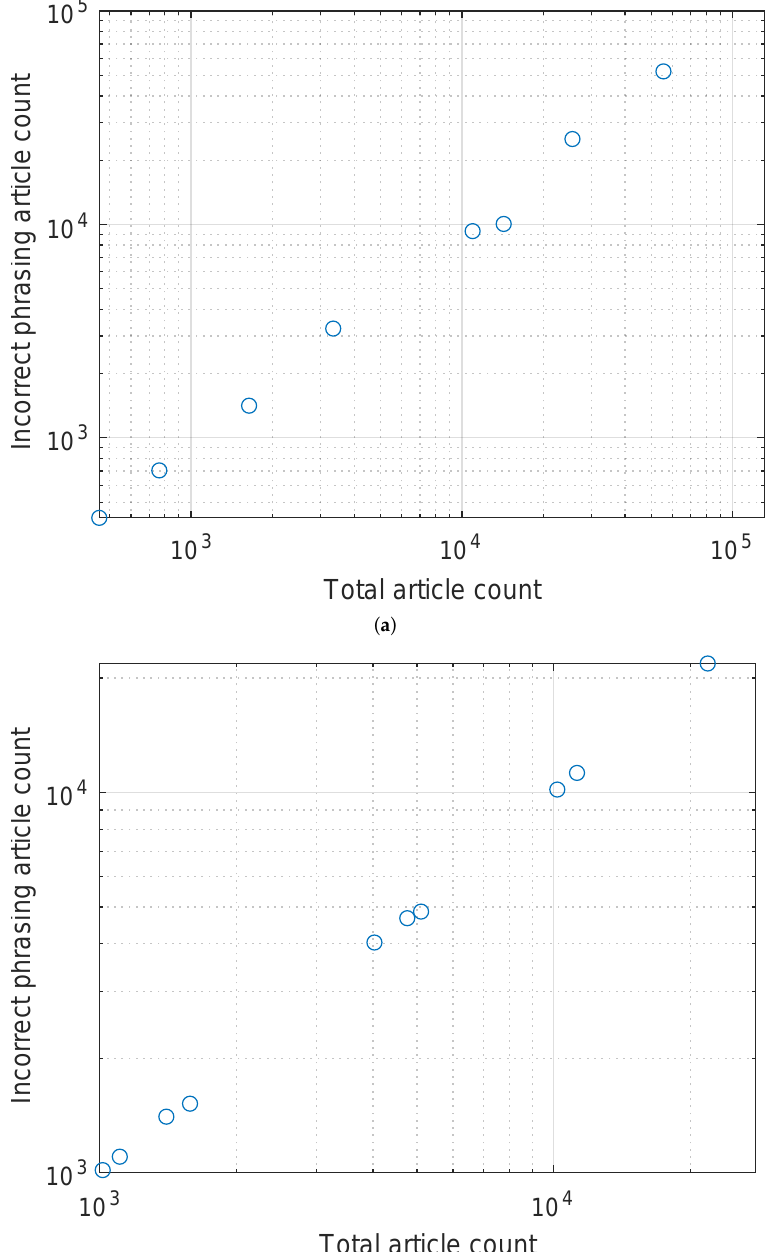
Figure 2. Relationship between the number of incorrectly phrased articles and the total number of articles reporting COVID-related deaths for ( a ) the UK and ( b ) the USA. A highly linear behaviour is readily observed, with the corresponding Pearson’s ρ equal to 0.998 and 1.000,